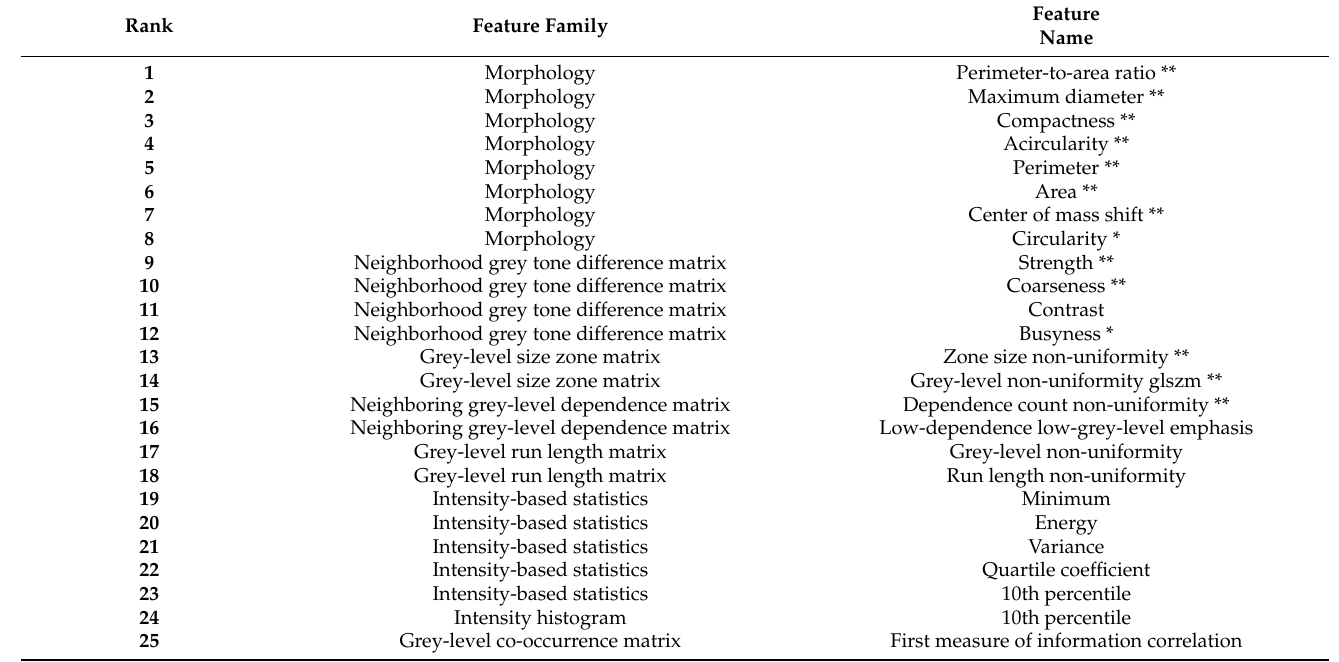
Table 4. Ensemble of support vector machines. Top 25 most relevant predictors sorted in descending order of